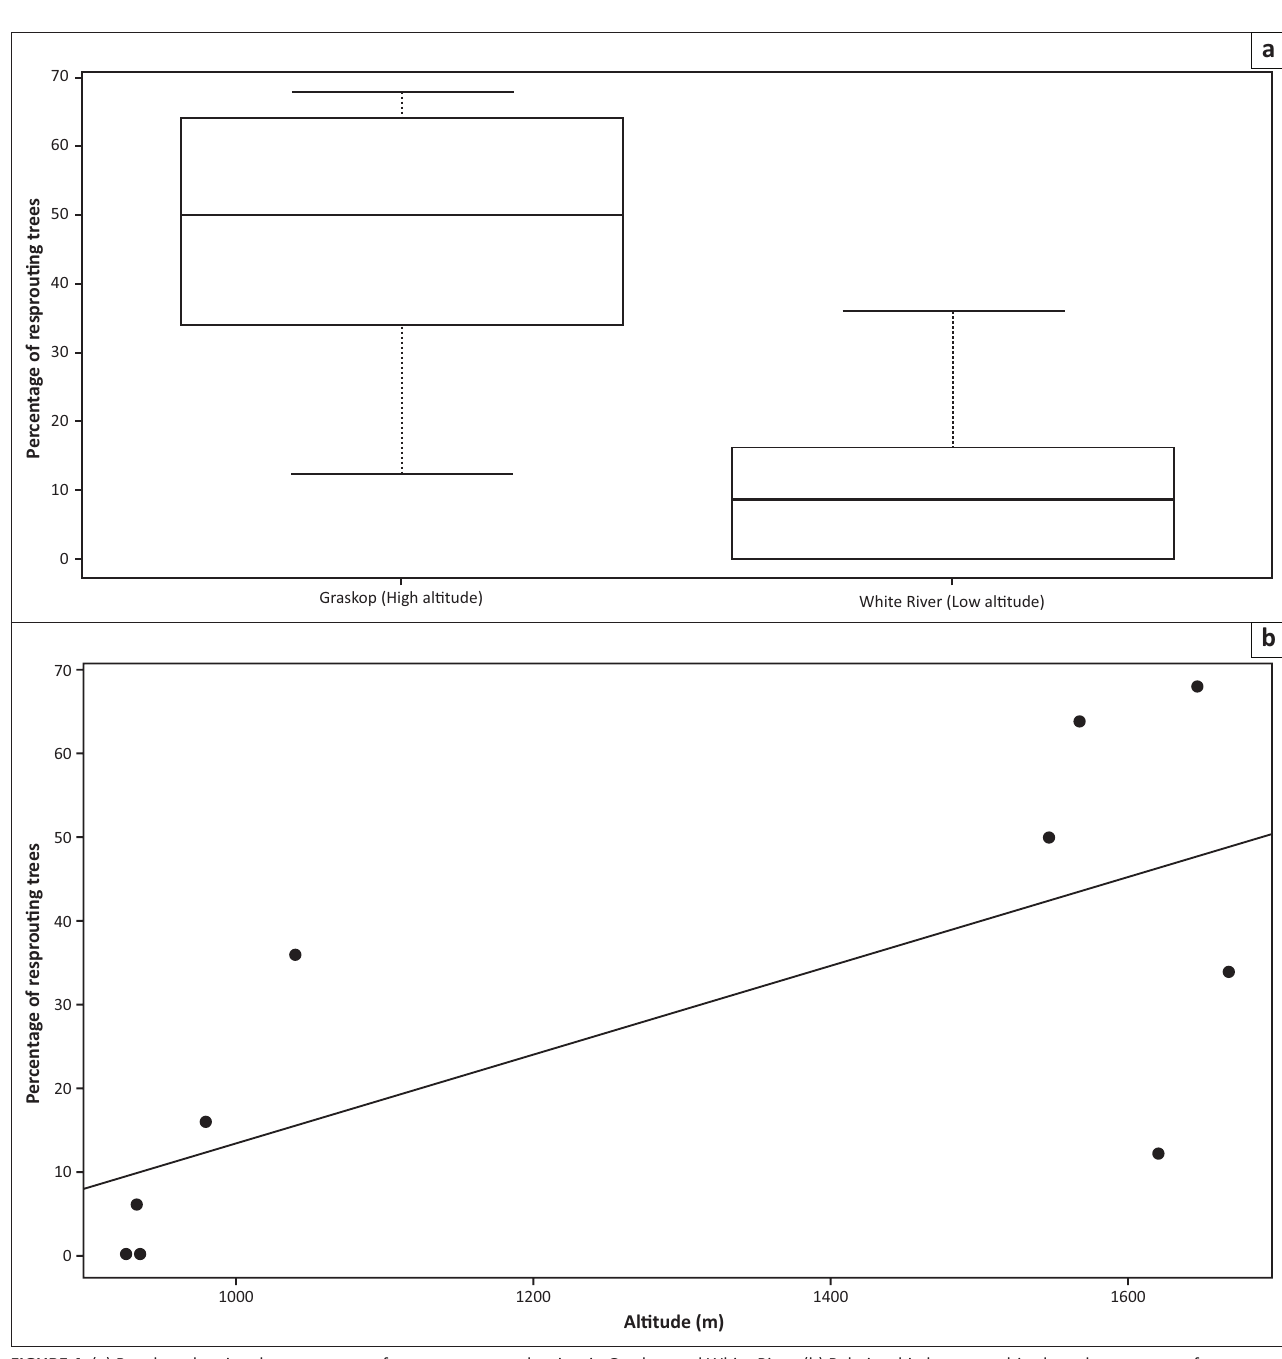
FIGURE 4: (a) Boxplots showing the percentage of resprouts across the sites in Graskop and White River. (b) Relationship between altitude and percentage of